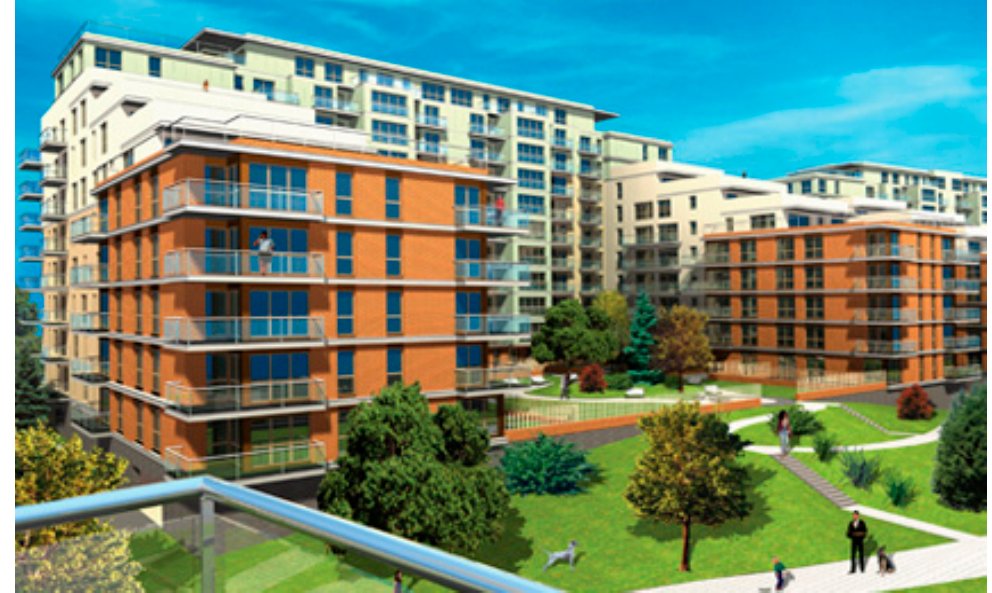
Figure 17. Buildings of the “Oak Terraces” housing estate in Katowice (project visualization, advertising materials, Tringranit).